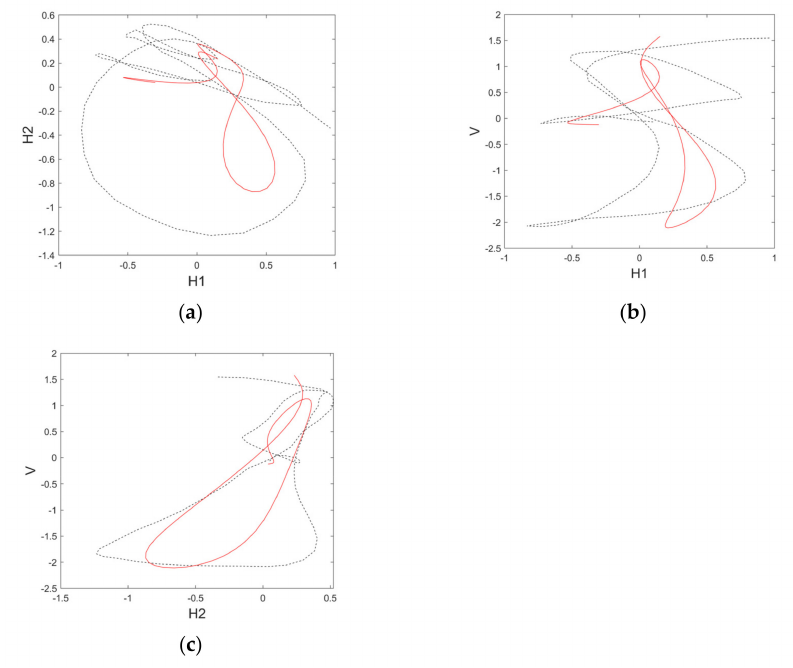
Figure 11. The hodograms of microseismic event data after denoising using re-constrain VMD. The black dotted lines represent the polarization characterization before denoising, and the red solid lines represent the polarization characterization after denoising. ( a ) The horizontal component H1 vs. horizontal component H2 hodogram. ( b ) The horizontal component H1 vs. vertical component V hodogram. ( c ) The horizontal component H2 vs. vertical component V